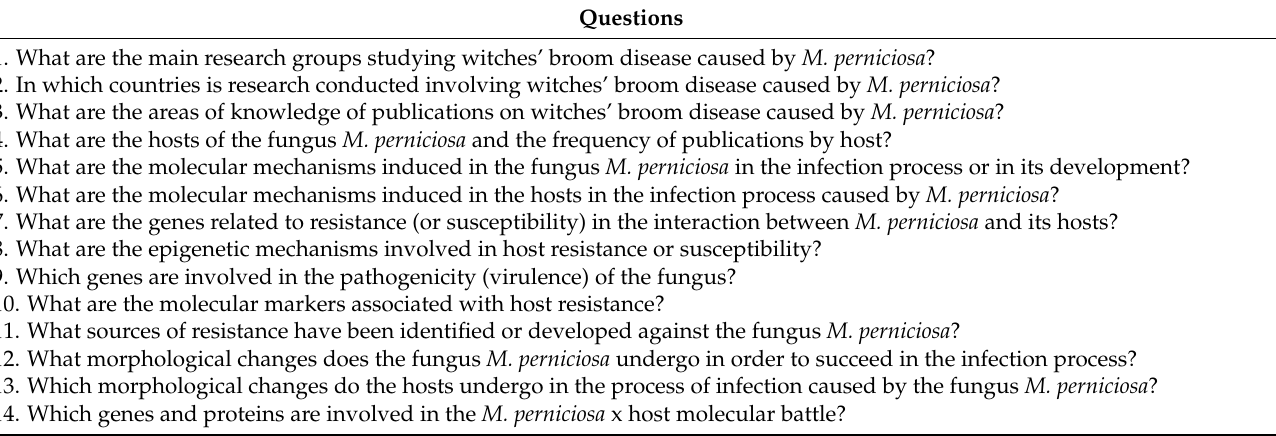
Table 1. Questions designed for the systematic review.